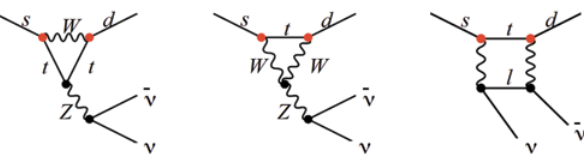
Figure 1. Z-penguin diagrams and box diagram contributing to the process K → πν ¯ ν